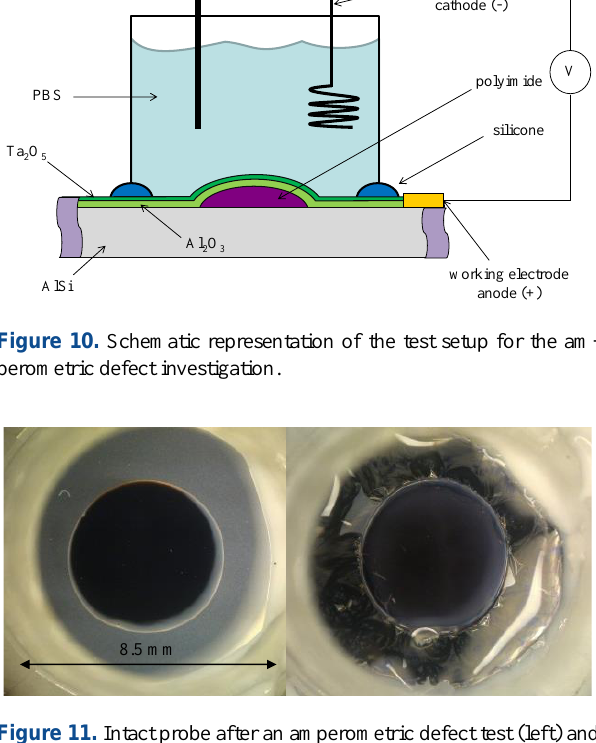
Figure 11. Intact probe after an amperometric defect test (left) and a sample having a defect in the ALD passivation (right). The sacri- ficial AlSi layer is completely